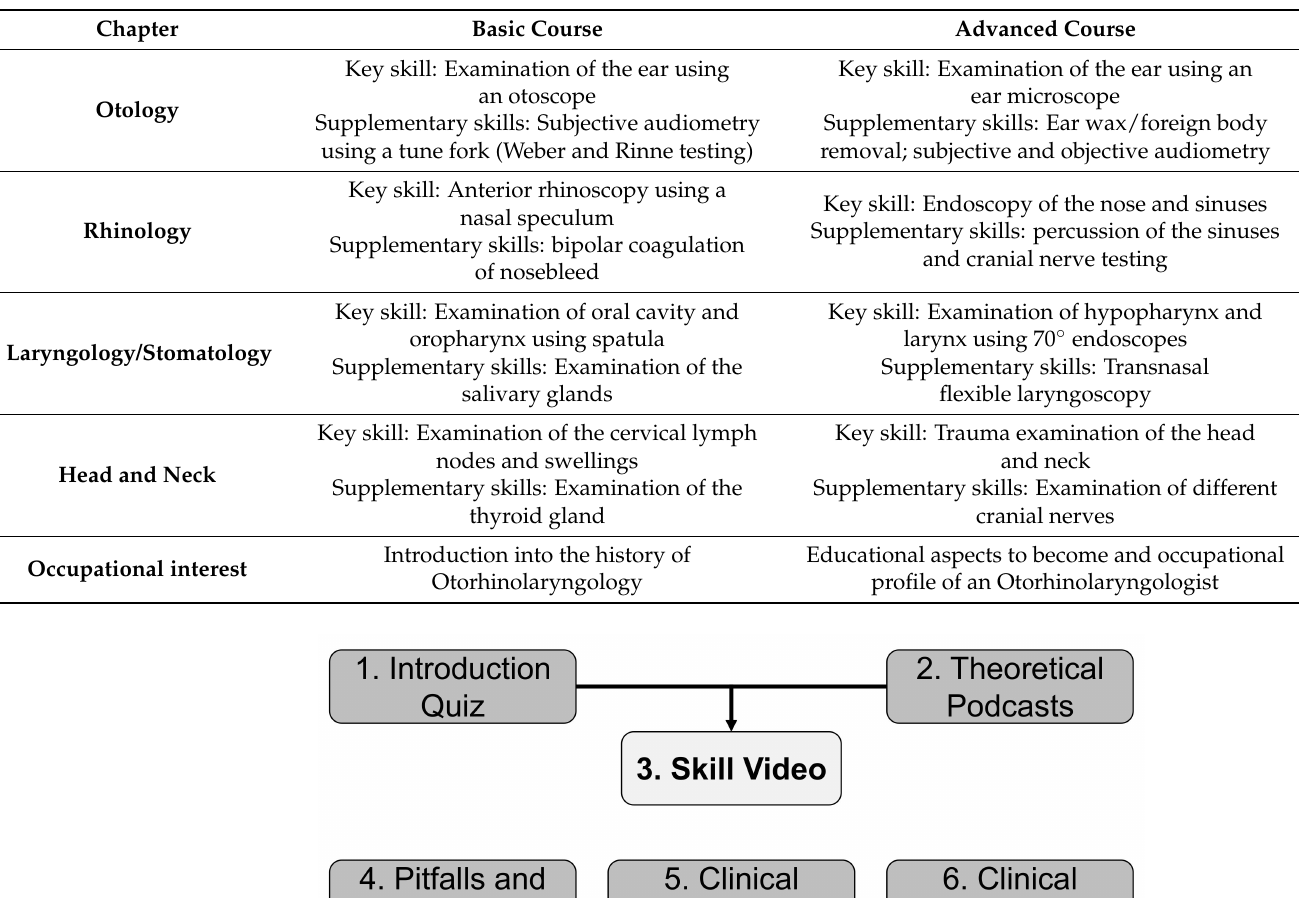
Table 1. Simplified course content of the new ToSkORL (Teaching of Skills in Otorhinolaryngology) online courses.